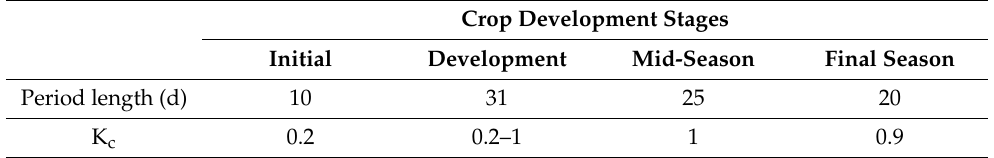
Table 2. Okra crop coefficients Kc and stage development length.